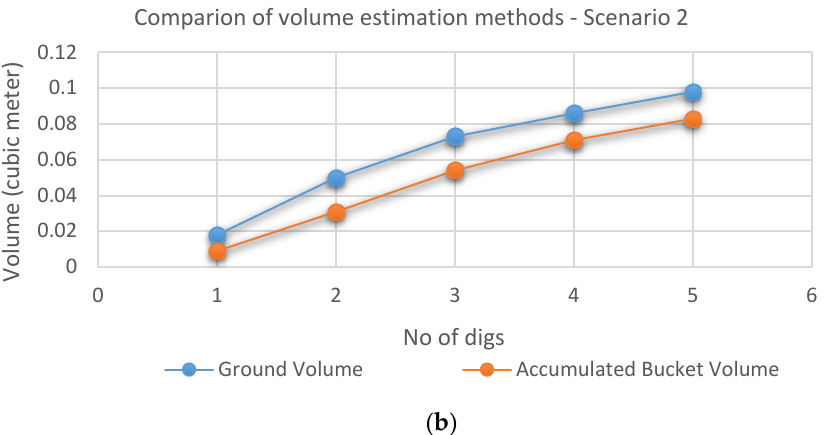
Figure 18. Comparison of the results of excavated volume estimation: ( a ) Scenario 1; ( b ) Scenario 2.